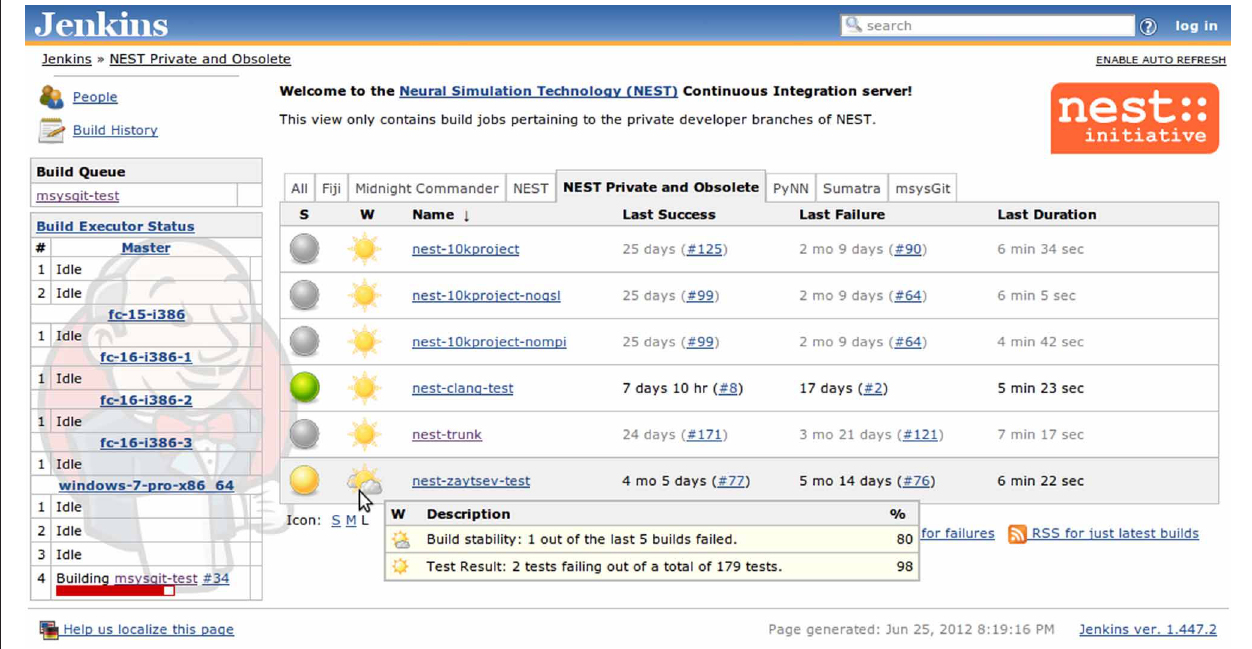
several indicators, such as stability, test results, code coverage, and static analysis (not illustrated), etc., as well as links to the individual pages of the last successful and last failed builds. On the left-hand side there is an additional table that shows the build queue and the current status of the available builders.